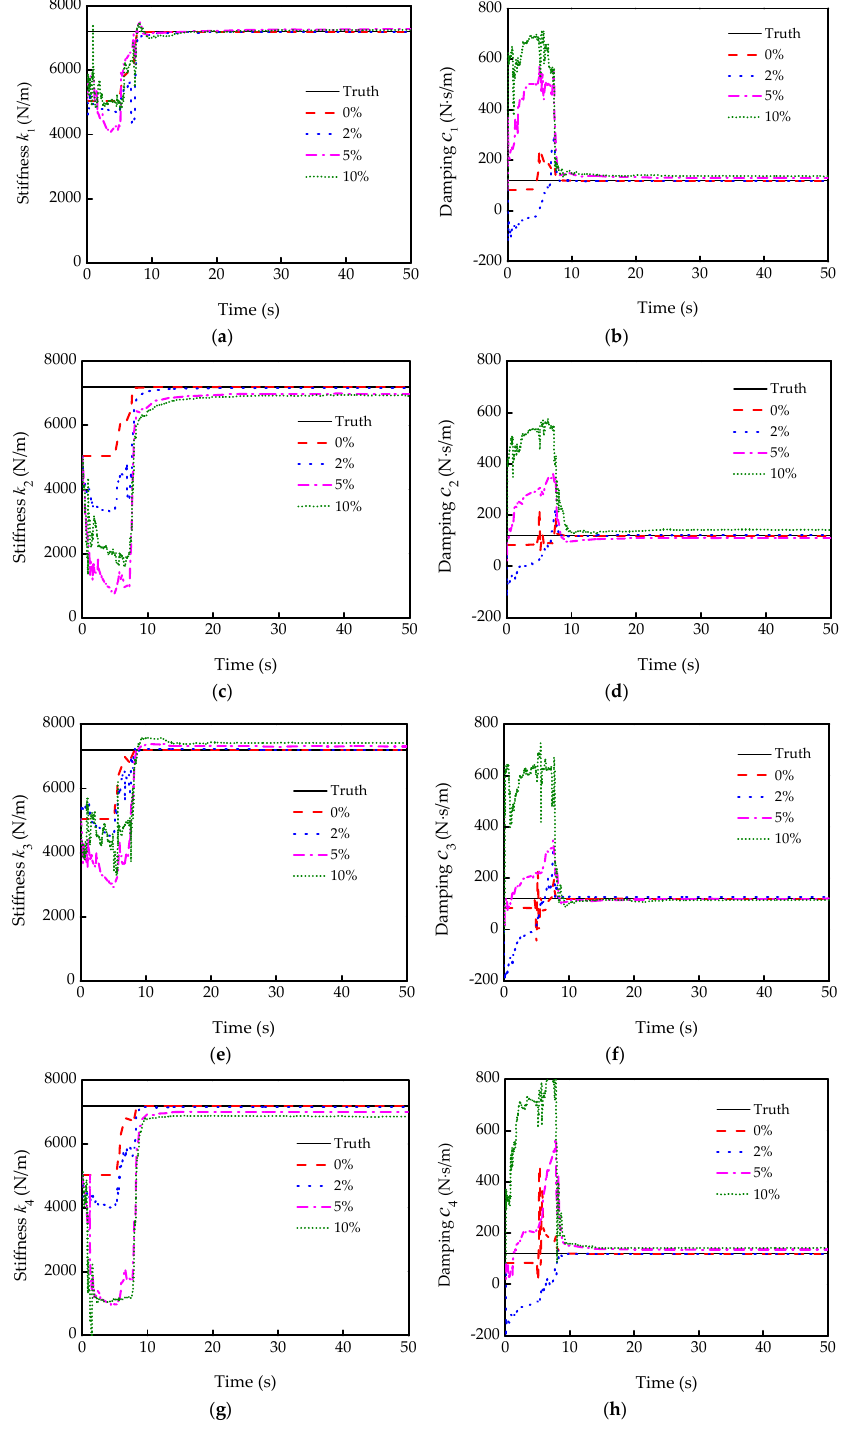
Figure 9. Identification results under different levels of non-Gaussian noise: ( a , c , e , g ) are the stiffness k 1 , k 2 , k 3 , and k 4 , respectively; ( b , d , f , h ) are the damping c 1 , c 2 , c 3 , and c 4 , respectively. Table 1. Estimation errors of the identified results under Gaussian and non ‐ Gaussian noise conditions.